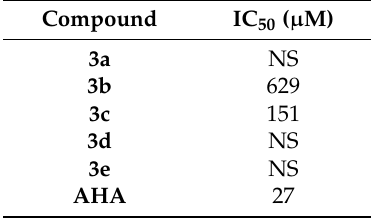
Table 4. Urease inhibition activity of the synthetic compounds. All compounds tested in the concentration range of 0.5–500 µ g/mL. The effect was considered significant if the inhibition was more than 60%. Acetohydroximic acid (AHA) was used as positive control. NS = not significant.